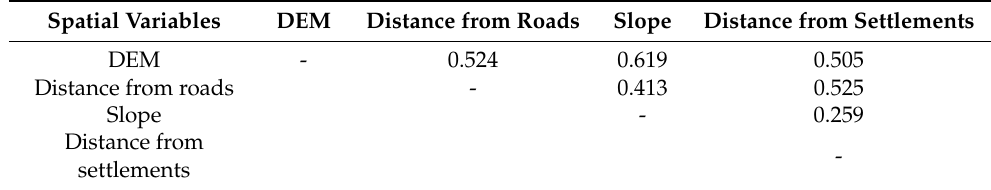
Table 2. Pearson’s correlation (r) values among spatial variables.